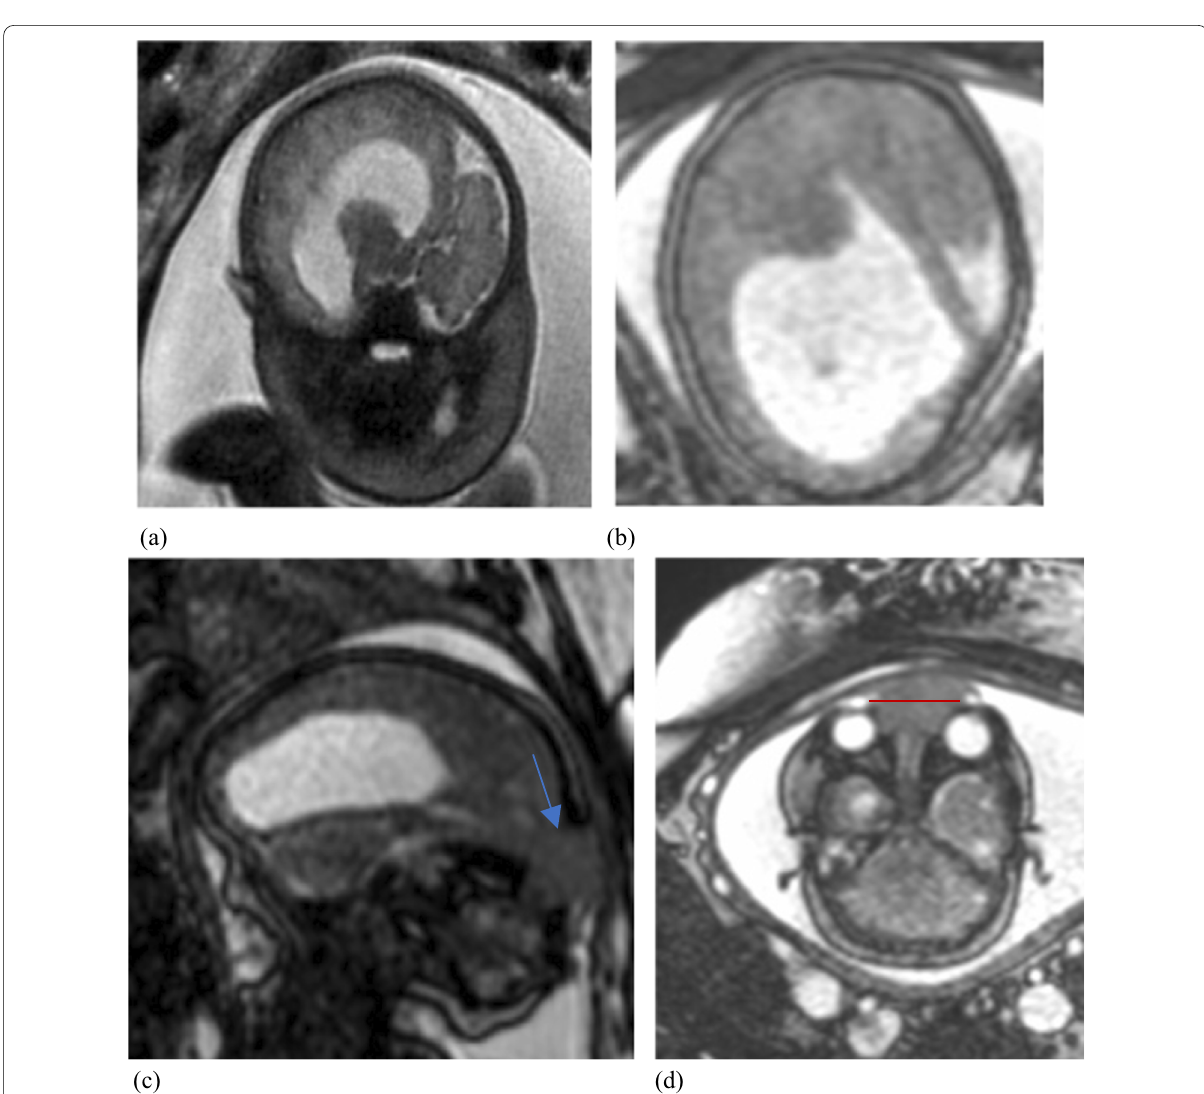
Fig. 3 Thirty-five-week fetus; prenatal ultrasound revealed sever left ventricular dilatation. SSFSE T2WIs coronal, axial planes a , b revealed enlarged left cerebral hemisphere, with dilated left lateral ventricle (reaching 30 mm) that shows colpocephaly. Small right cerebral hemisphere with attenuated right lateral ventricle. Sagittal and axial images at the frontal level c , d showed herniating brain parenchyma seen protruding through frontal cortical defect measures 2 cm (arrow) and extends antero-inferiorly between the eye globes that show mild hypertelorism (IOD No CSF signal seen surrounding the lesion. The corpus callosum could not be completely identified. MRI diagnosis: Left hemimegalencephaly with sever ipsilateral ventriculomegaly and frontal encephalocele as well as CC dysgenesis. Recommendation: Termination of